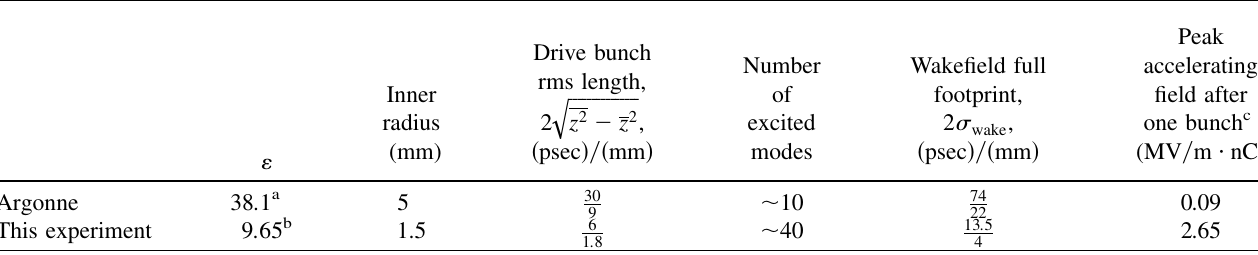
TABLE I. Comparison of the